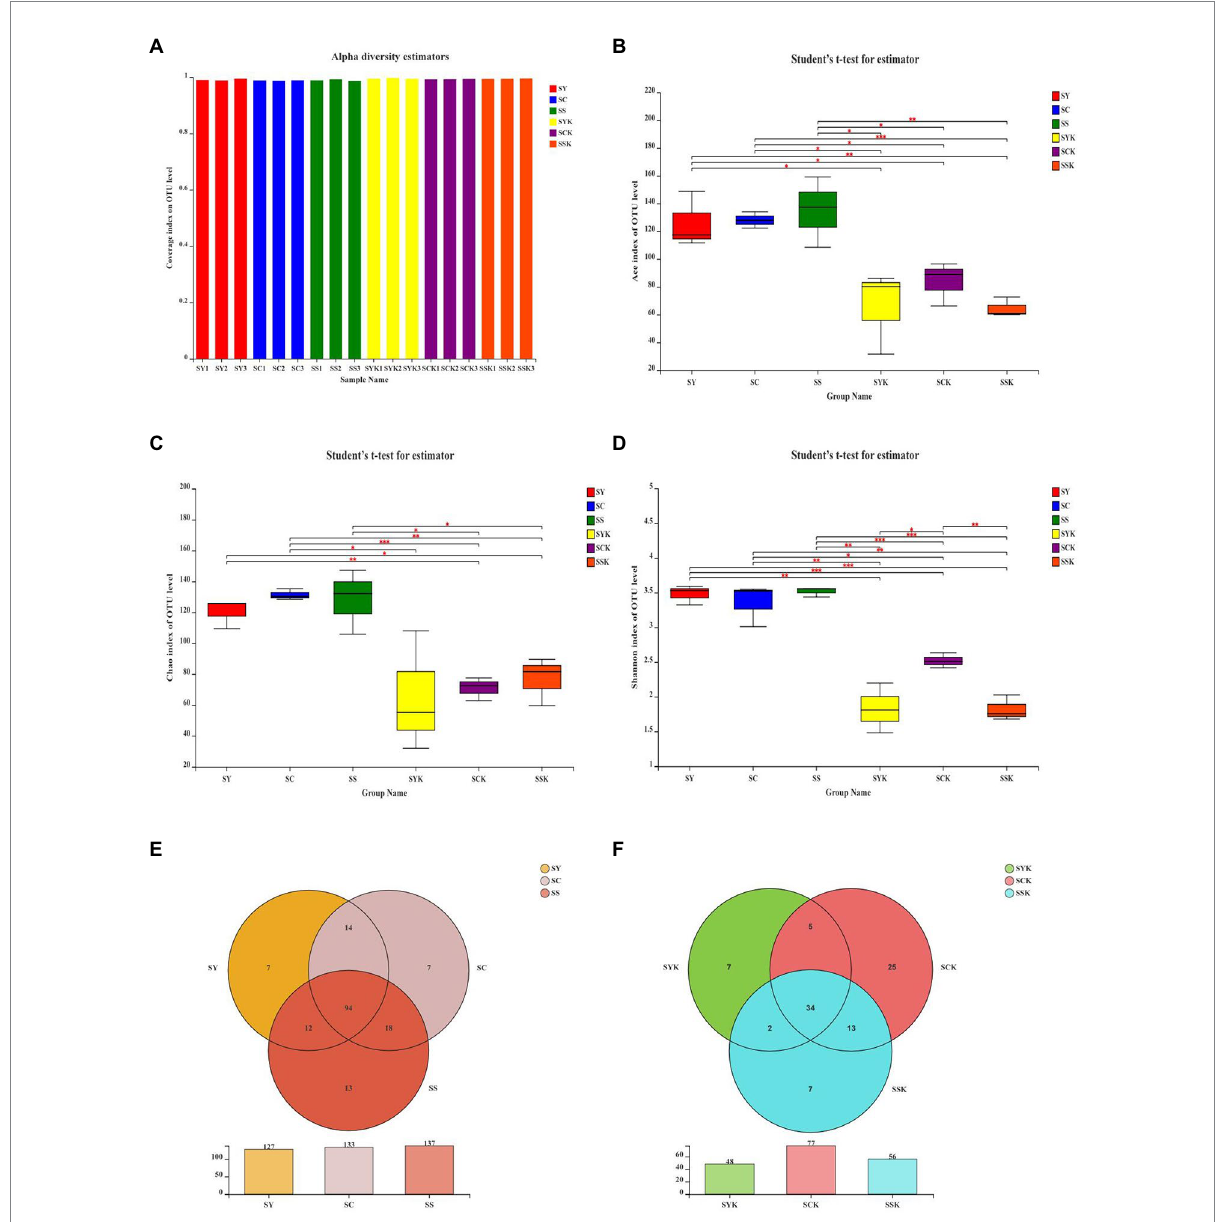
FIGURE 1 Alpha-diversity of the bacterial community of fresh materials and ryegrass silages and Venn analysis of OTUs. (A–D) the Coverage, ACE, Chao1 and Shannon index of the bacterial community of fresh materials and ryegrass silages, respectively. ‘*,’ ‘**,’ and ‘***’ represent p < 0.05, p < 0.01, and p < 0.001, respectively. (E) Venn analysis of OTUs in the bacterial community of fresh materials; (F) Venn analysis of OTUs in the bacterial community of ryegrass silage; SY, Fresh materials at booting stage; SC, Fresh materials at initial flowering; SS, Fresh materials at full flowering; SYK, Silage samples at booting stage; SCK, Silage samples at initial flowering; SSK, Silage samples at full